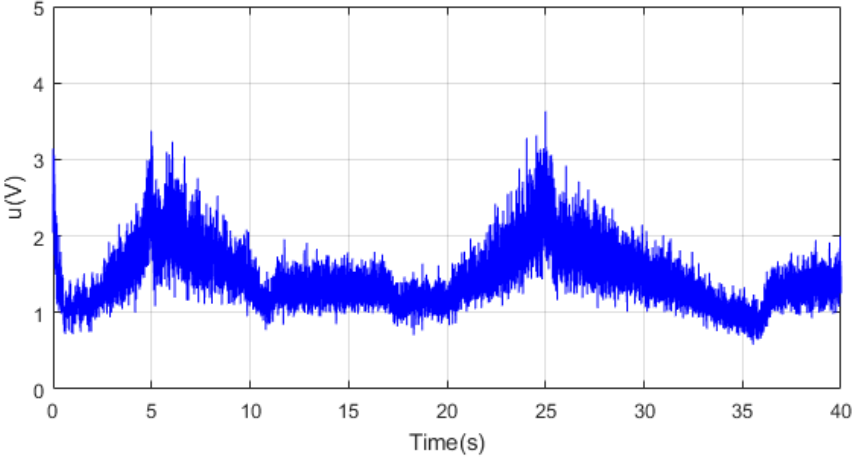
Figure 26. Control signal for the random reference applied by the inverse model controller with adaptive